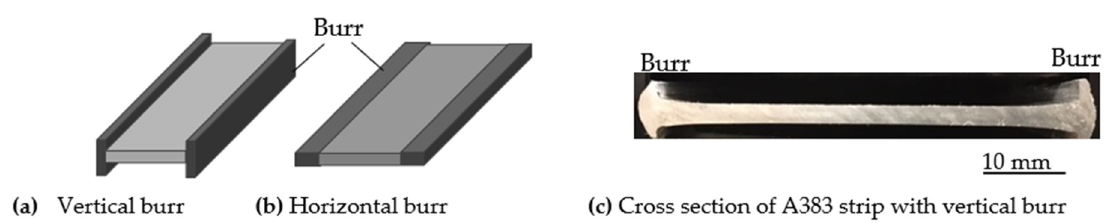
Figure 9. Schematic illustration of ( a ) vertical and ( b ) horizontal burrs and ( c ) photograph of a cross section of A383 strip with vertical burrs.